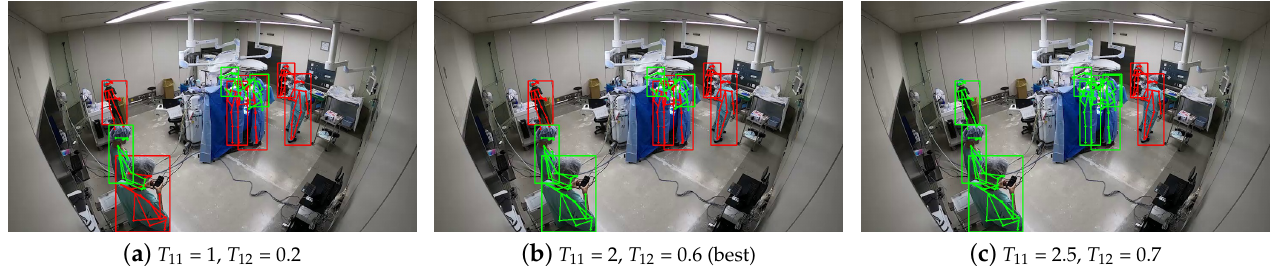
Figure 6. Estimated poses of corresponding bounding boxes. The green poses and bounding boxes represent those being filtered out, and the red ones represent those being